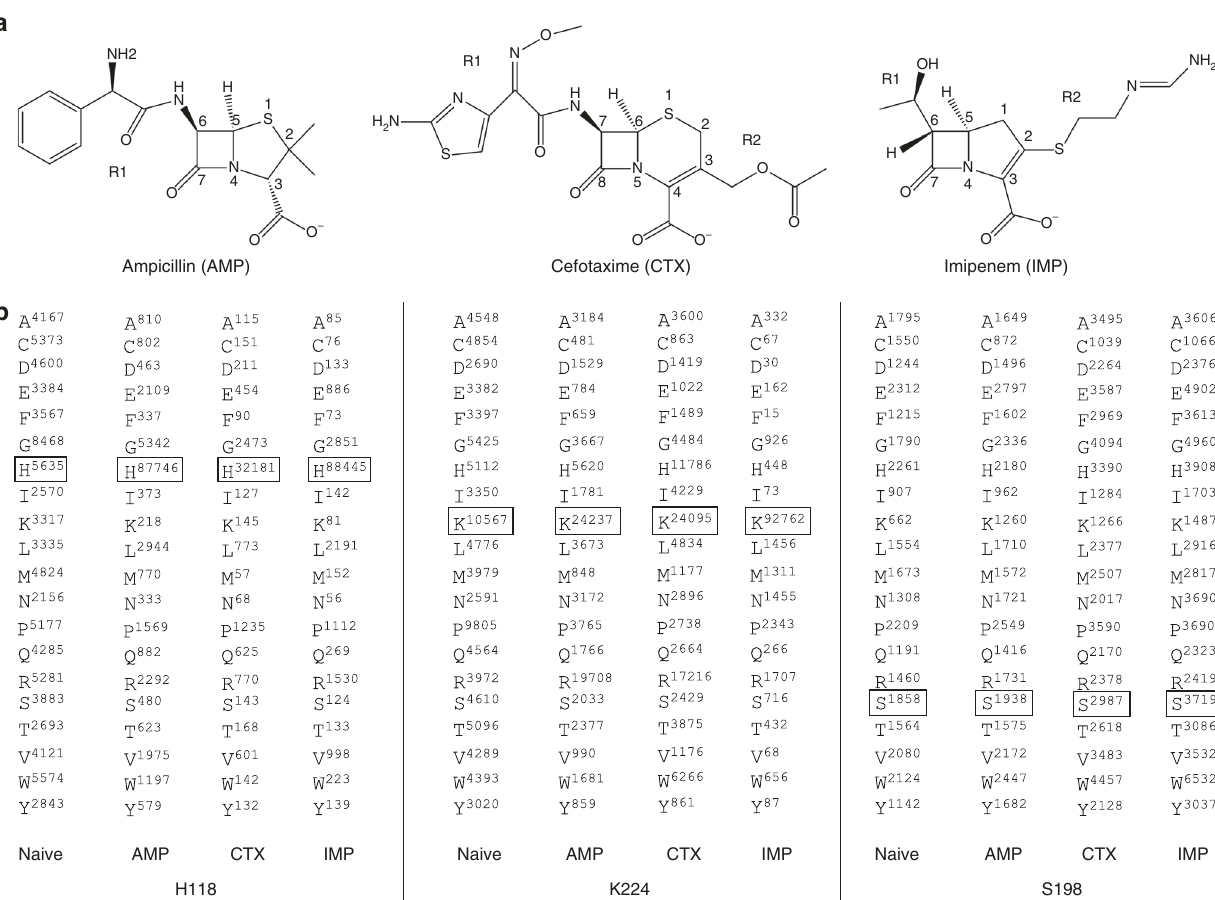
Fig. 2 Antibiotic structures and representative DNA sequencing results. a Structures of ampicillin, cefotaxime, and imipenem. The position of the R1 group is indicated on the structure of ampicillin and the R1 and R2 groups are indicated on the structures of cefotaxime and imipenem. b Representative DNA sequencing results of clones from naive and antibiotic-selected NDM-1 libraries. A total of 124 experiments from 31 libraries were sequenced and the results from three representative libraries are shown. The number of times the wild-type amino acid occurred in the sequenced library is boxed in each experiment. AMP ampicillin, CTX cefotaxime, IMP